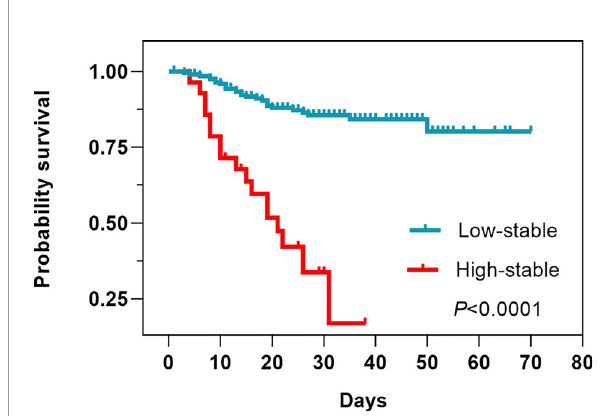
FIGURE 3 | Survival analysis between low-stable and high-stable pattern